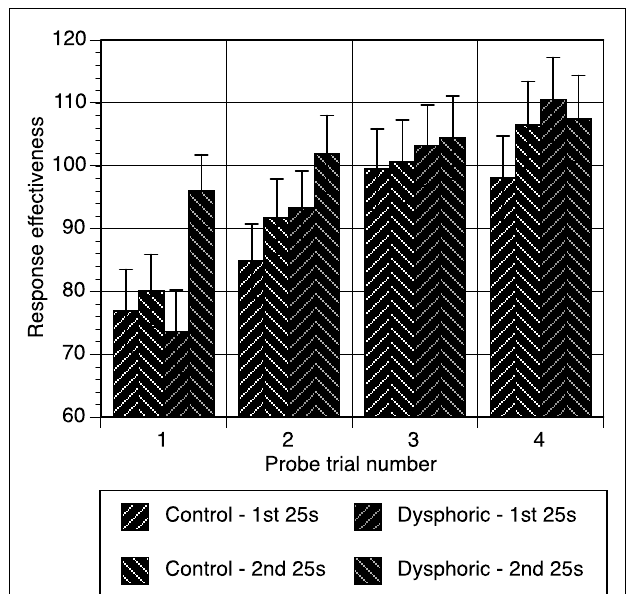
FIGURE 2 | Response effectiveness scores during the first 25s and second 25s of each probe trial for the control and dysphoric groups. Error bars correspond to the standard error of the